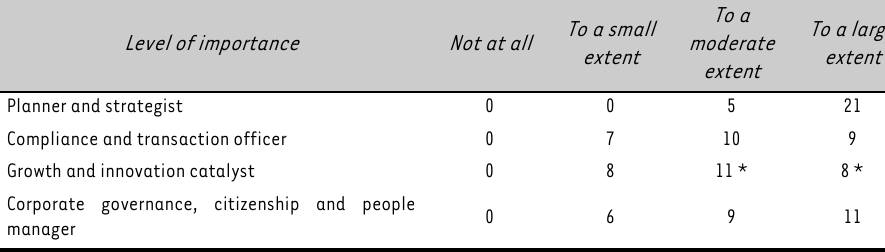
TABLE 10: Relative importance of roles now Level of importance Not at all